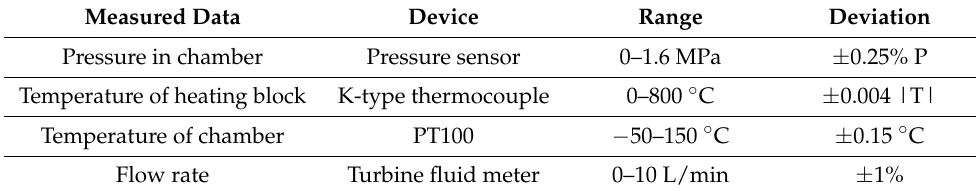
Table 1. Measured data and the